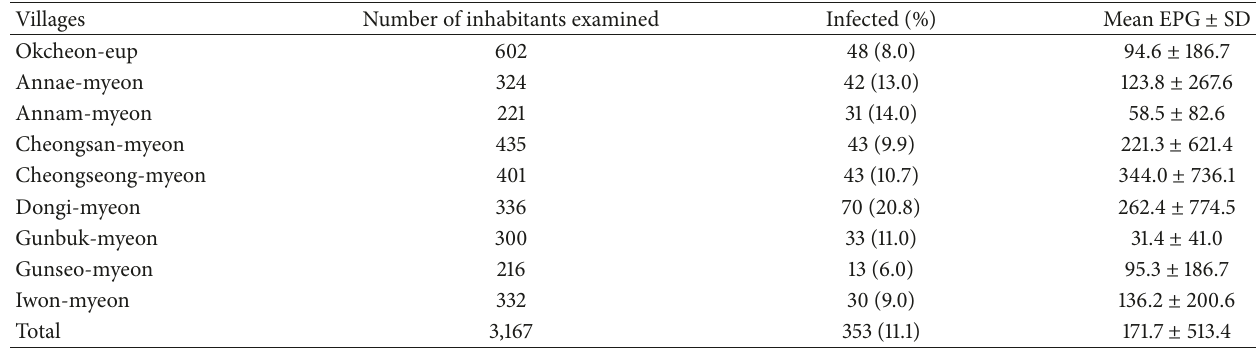
Table 2: Infection rates of C. sinensis according to surveyed area.